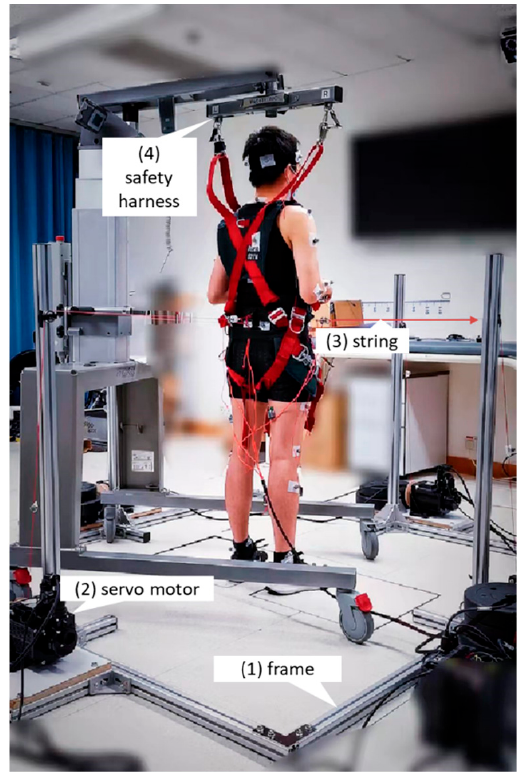
Figure 1. Experimental setup and the waist-pull system for inducing sudden balance perturbations in anterior, posterior, medial, and lateral directions.